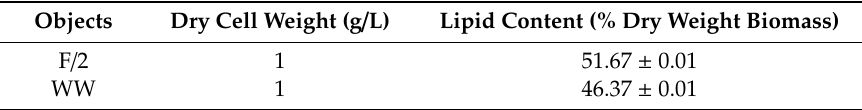
Table 3. Dry cell weights and lipid concentrations under